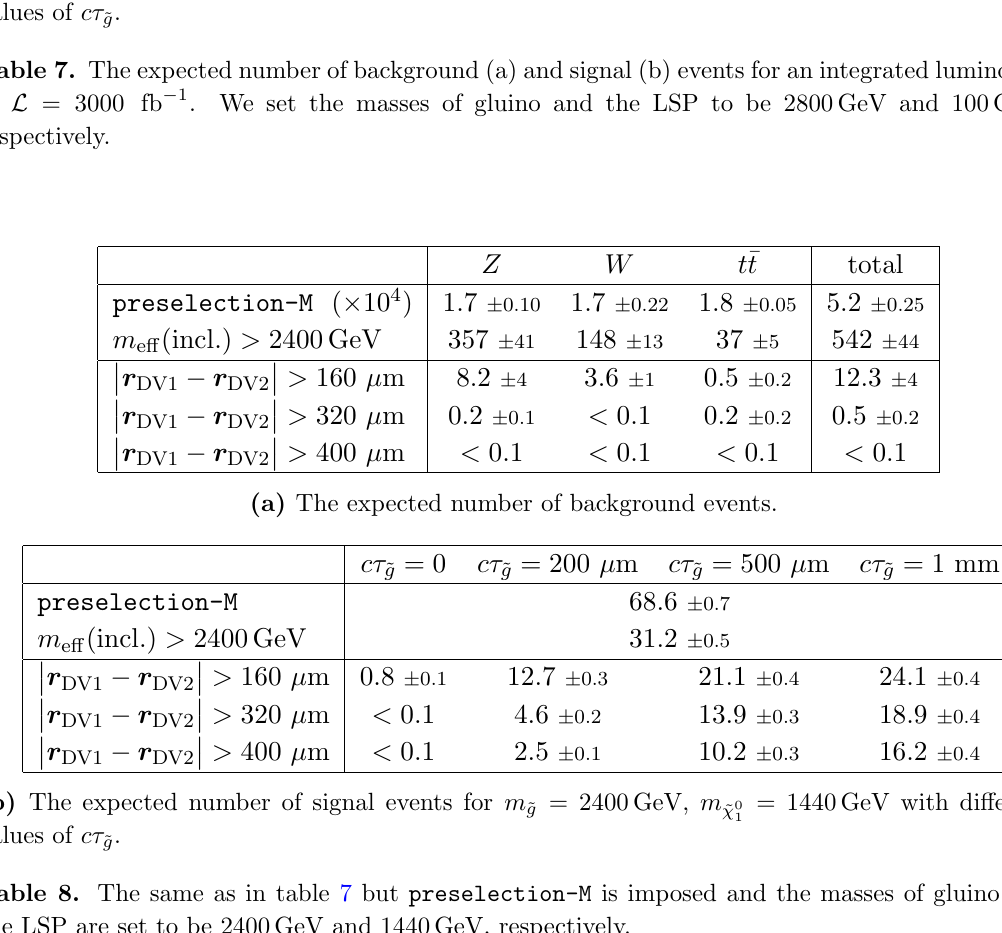
Table 8. The same as in table 7 but preselection-M is imposed and the masses of gluino and the LSP are set to be 2400 GeV and 1440 GeV,